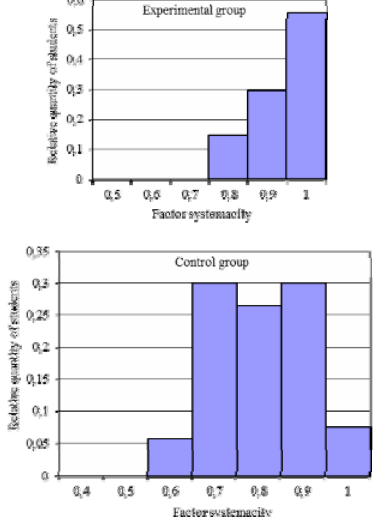
Figure 5. Histograms of students distribution by К s